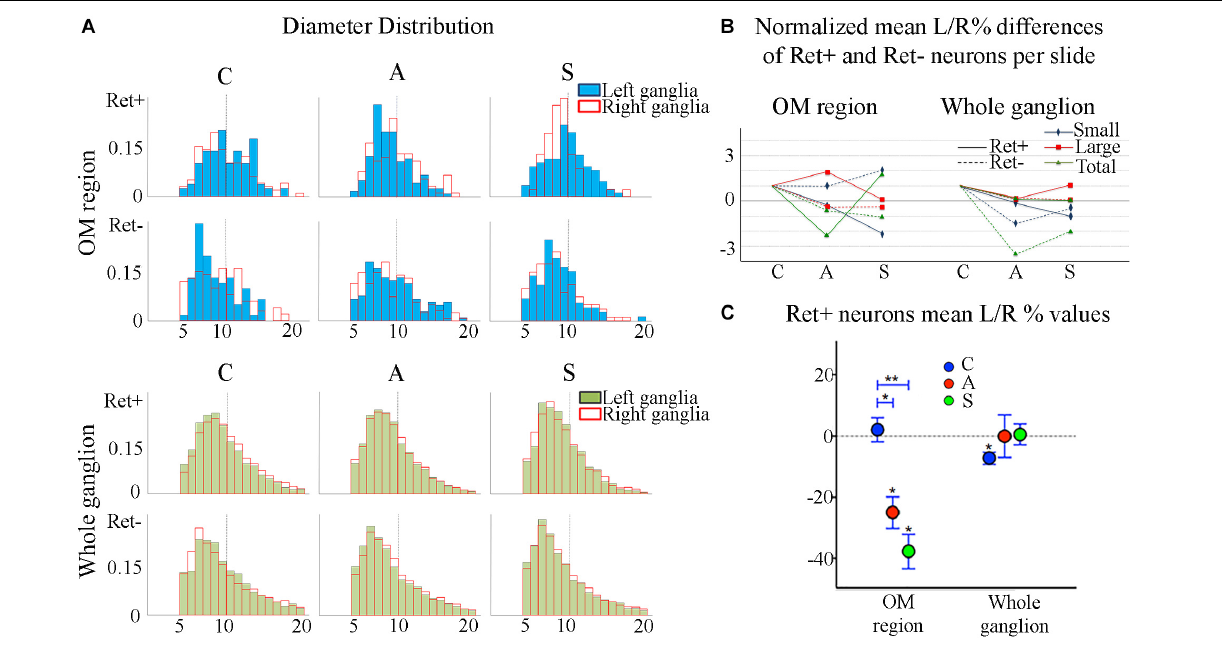
Frontiers in Neuroscience |